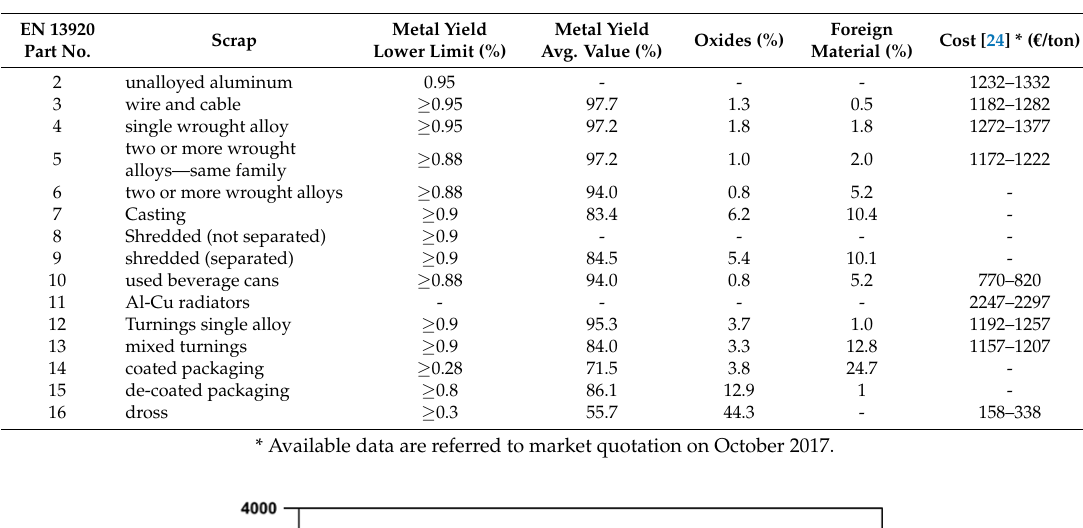
Table 1. Classification of Al scrap showing the metal yields (lower limit and average value), the average amounts of undesired materials (oxides and foreign materials) and the cost. Data are read and elaborated from the different parts of EN 13920 standard [23].